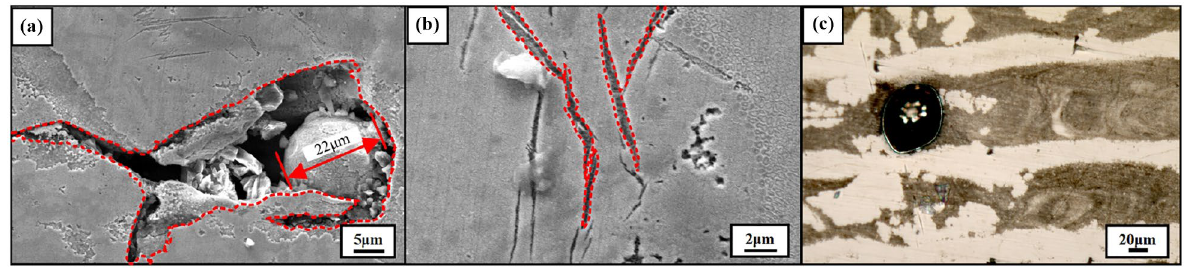
Figure 8 Typical forming defects a irregularly shaped pores due to insufficient melting; b and c micro-cracks and balling in SLM HSS sample due to over-high laser